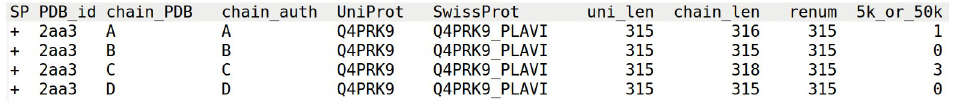
Fig 4. Log file of PDBrenum on PDB entry 2aa3. In this logfile, “SP” means “special case” and denotes which chains were handled in specific ways. It is “+” for cases where there is no clash in UniProt numbers. It is “ � ” for the case where a chain has more than one UniProt in SIFTS; the UniProt that represents the largest portion of the chain is taken unless it is in the exception list of UniProts often used as crystallization chaperones [GFP_AEQVI, GCN4_YEAST, C562_ECOLX, ENLYS_BPT4, MALE_ECOLI]. PDB_id is the 4-character long PDB identifier; chain_PDB is the chain identifier given by the PDB in mmCIF files (label_asym_id); chain_auth is a chain identifier given by authors of the structure (auth_asym_id); UniProt is the 6-character long UniProt identifier (e.g. Q4PRK9); SwissProt is the human- readable UniProt identifier (e.g., P53_HUMAN); uni_len is the number of residues in the chain represented in the UniProt sequence; chain_len represent the length of the chain sequence; renum represents total quantity of residues that were renumbered according to UniProt; 5k_or_50k represents quantity of residues that were renumbered by adding 5000 to 1-to-N numbering for the PDB-legacy format or adding 50000 to the 1-to-N numbering for the mmCIF